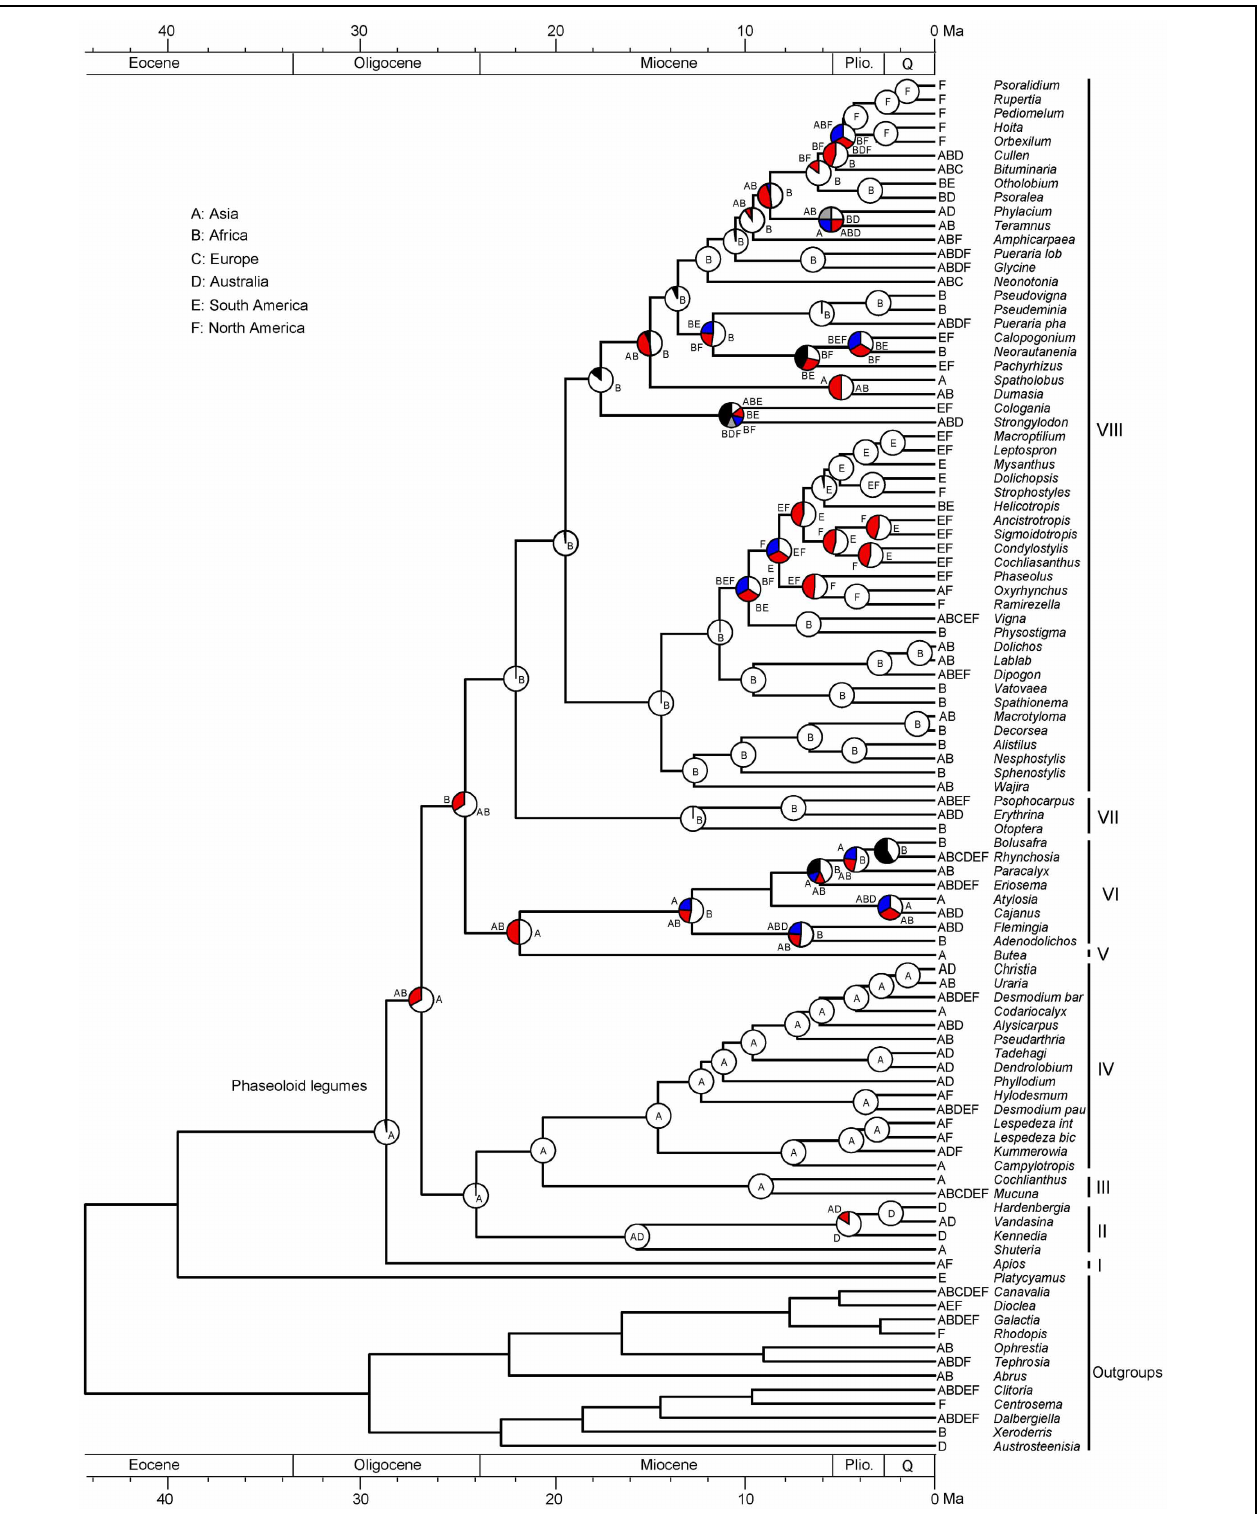
FIGURE 3 | Biogeographical reconstruction of the phaseoloid legumes. The pie charts show the relative probabilities of alternative ancestral distributions obtained by Bayes-DIVA optimizations over the 1000 Bayesian